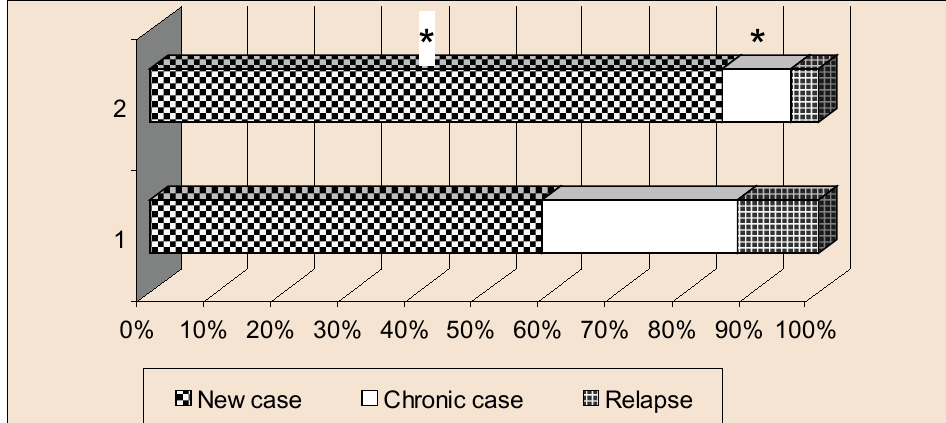
Figure 3. Characteristics of tuberculosis in patients who carried M.tuberculosis either with mutation (1) or without mutation (2) in katG gene.